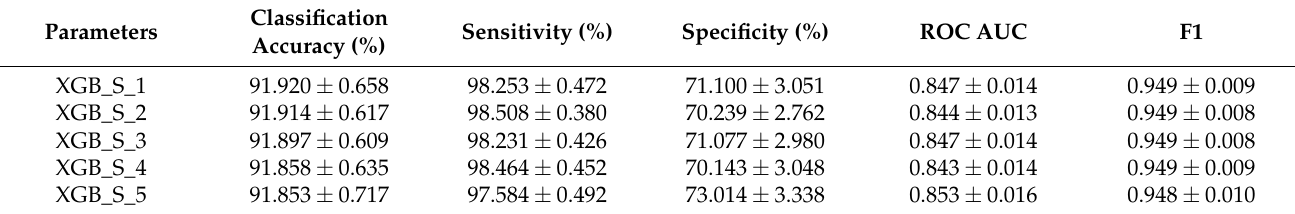
Table 8. Best results for the XGBoost algorithm (static analysis).